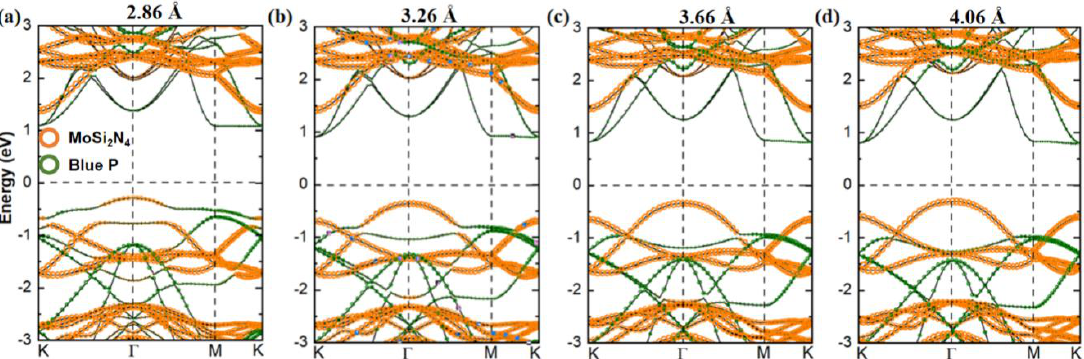
Figure 9. Projected band structures of the Blue P/MoSi 2 N 4 vdWH under the vertical interspaces of ( a ) 2.86, ( b ) 3.26, ( c ) 3.66, and ( d ) 4.06 Å. In these panels, the Fermi levels were set to zero.